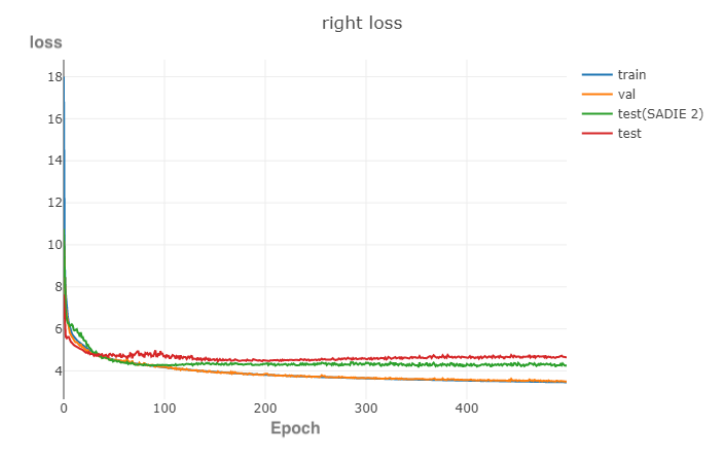
Figure 10. Right channel L1 loss during training (blue: training loss, orange: validation loss, green: hold out test data Subject 20 from SADIE II, red: Bernschutz KU100), which shows that the lowest point in the curve is at around 110